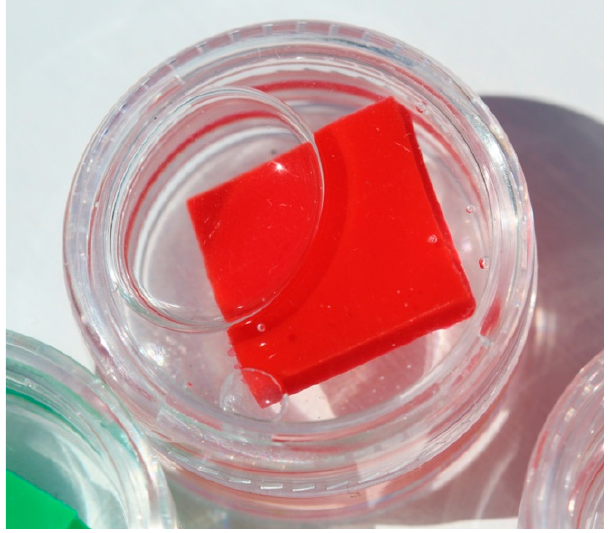
Figure 1. EVA sample in a separate container prepared for incubation.